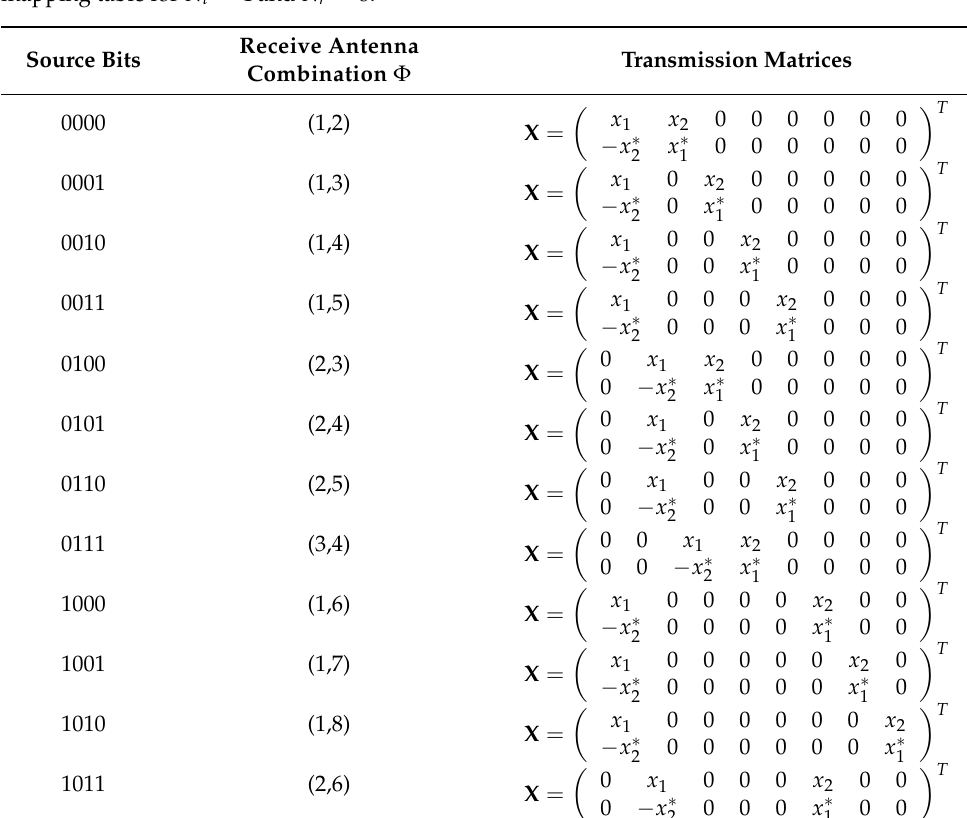
Figure 1. System model. Table 1. Space-Time Block Code (STBC)-Cooperative Multiple-Input Multiple-Output (CMIMO) mapping table for N t = 4 and N r =